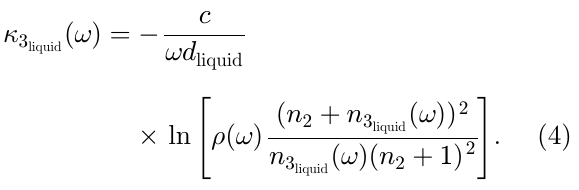
Fig. 1. Transmission schematics for the liquid sample cell geometry. This schematic illustrates the notation for specifying T-rays radiation propagation through liquid sample, inserted in polymer window